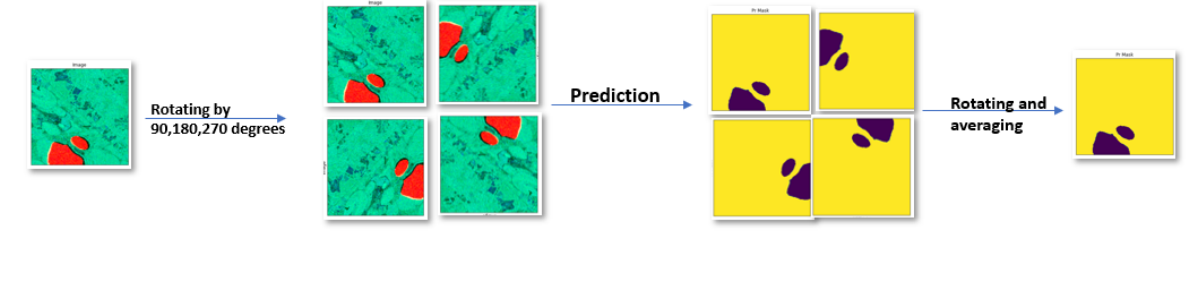
Figure 7. Augmentation of test data by rotating each tile by 90, 180 and 270 degrees and predicting the flood mask by applying the trained model on each of the augmented tile.